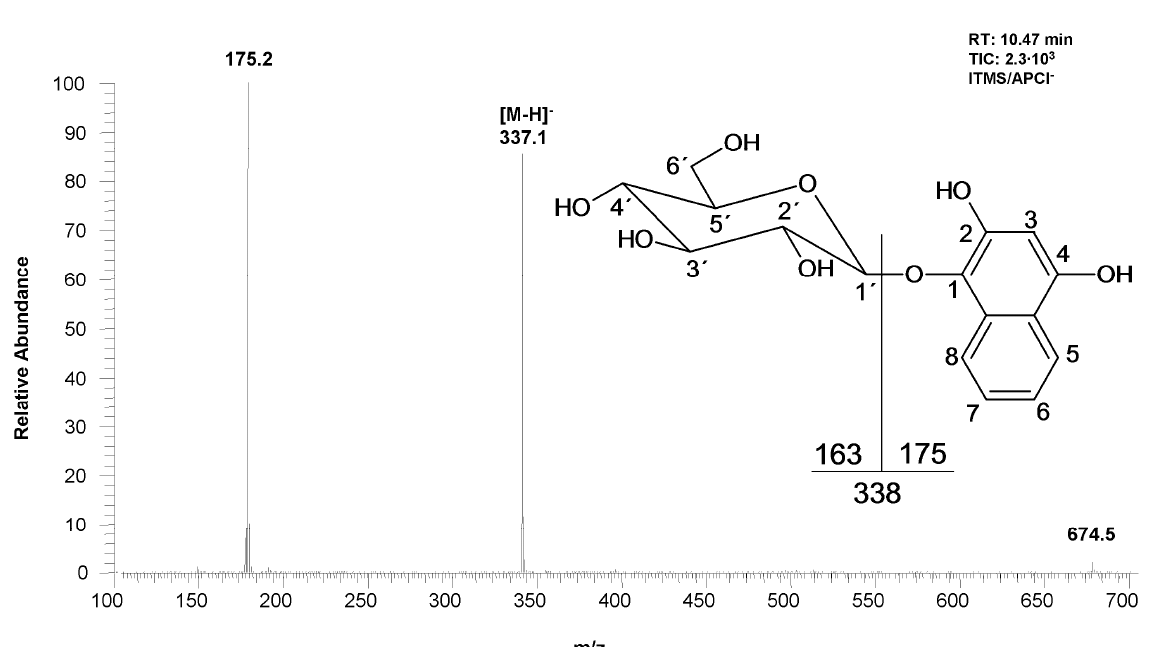
Figure 3. Mass spectrum and chemical structure of the 1,2,4-trihydroxynaphthalene-1- O